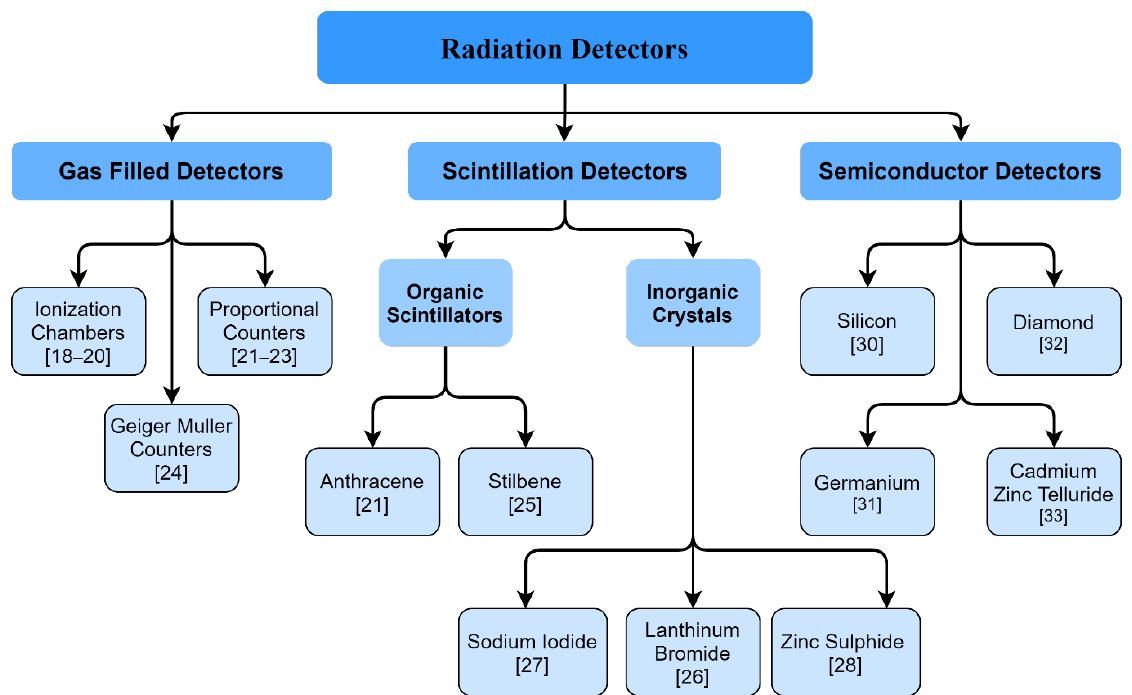
Figure 1. The classification of radiation detectors that are being used in radiation monitoring.